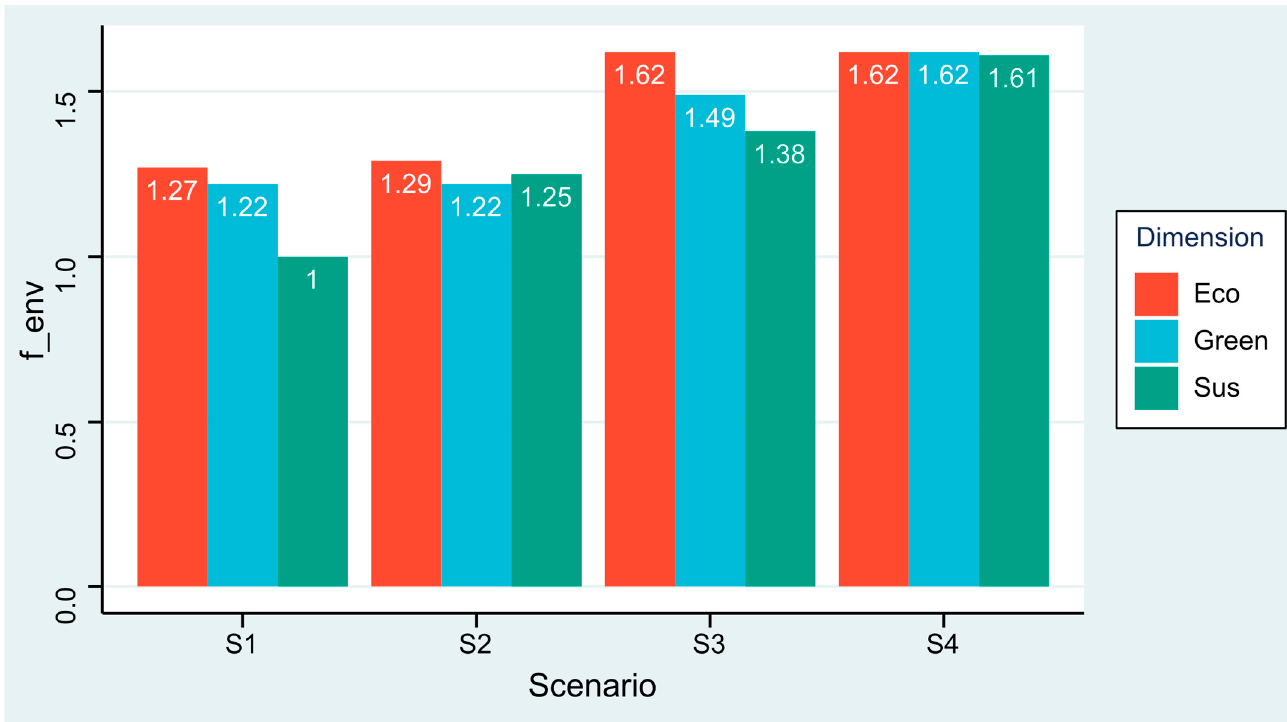
Figure 5. Results of the sensitivity analysis of the sustainability dimension of 𝑓 (cid:3032)(cid:3030)(cid:3042) .